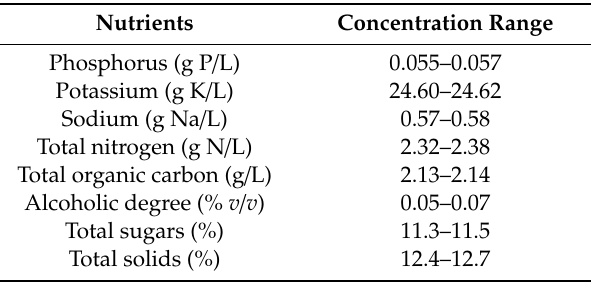
Table 4. Chemical composition of vinasse.